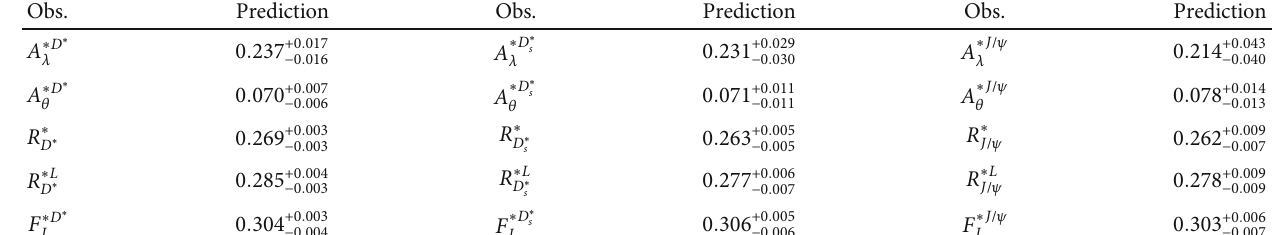
Obs. Prediction Obs.